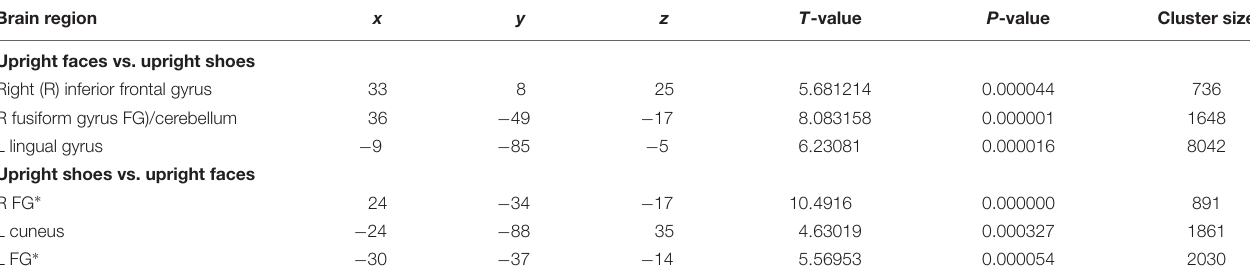
TABLE 2 | Categorical effects, including only upright stimuli. Brain region x y z T -value P -value Cluster size